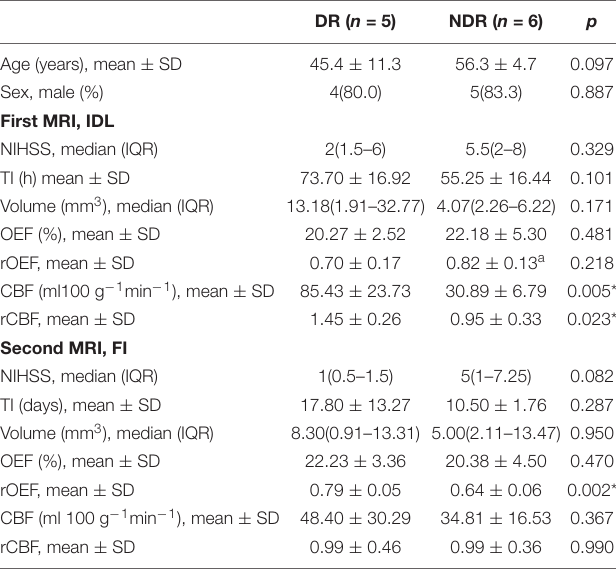
TABLE 2 | Characteristics of patients with and without diffusion